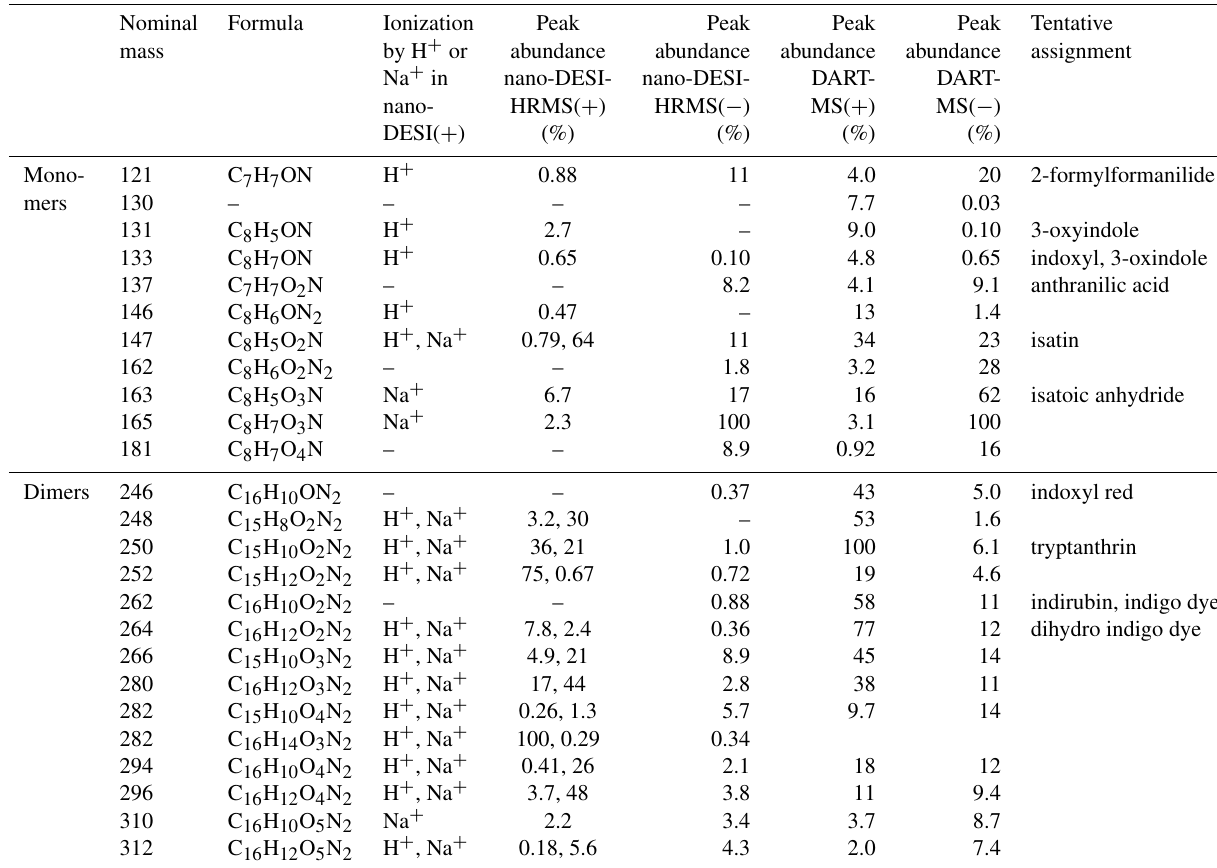
Table 1. Monomer and dimer peaks with the largest peak abundance observed in DART-MS and nano-DESI-HRMS spectra. Selected peaks corresponding to the compounds shown in Fig. 1 are also included. Proposed assignments are based on the formulas from nano-DESI-HRMS. Peak abundances are normalized with respect to the most abundant peak in each